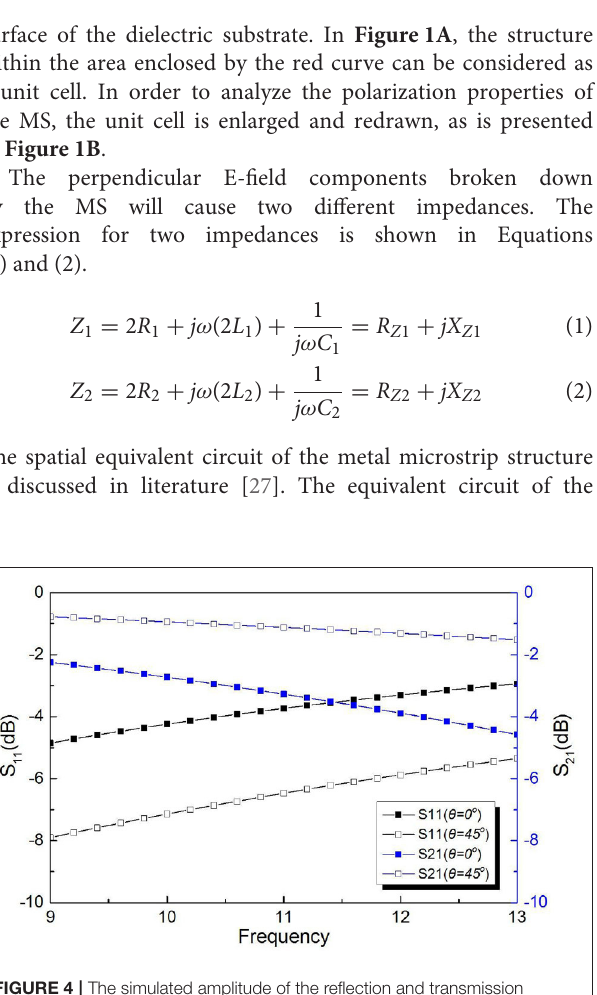
FIGURE 4 | The simulated amplitude of the reflection and transmission coefficients of the metasurface’s unit cell.